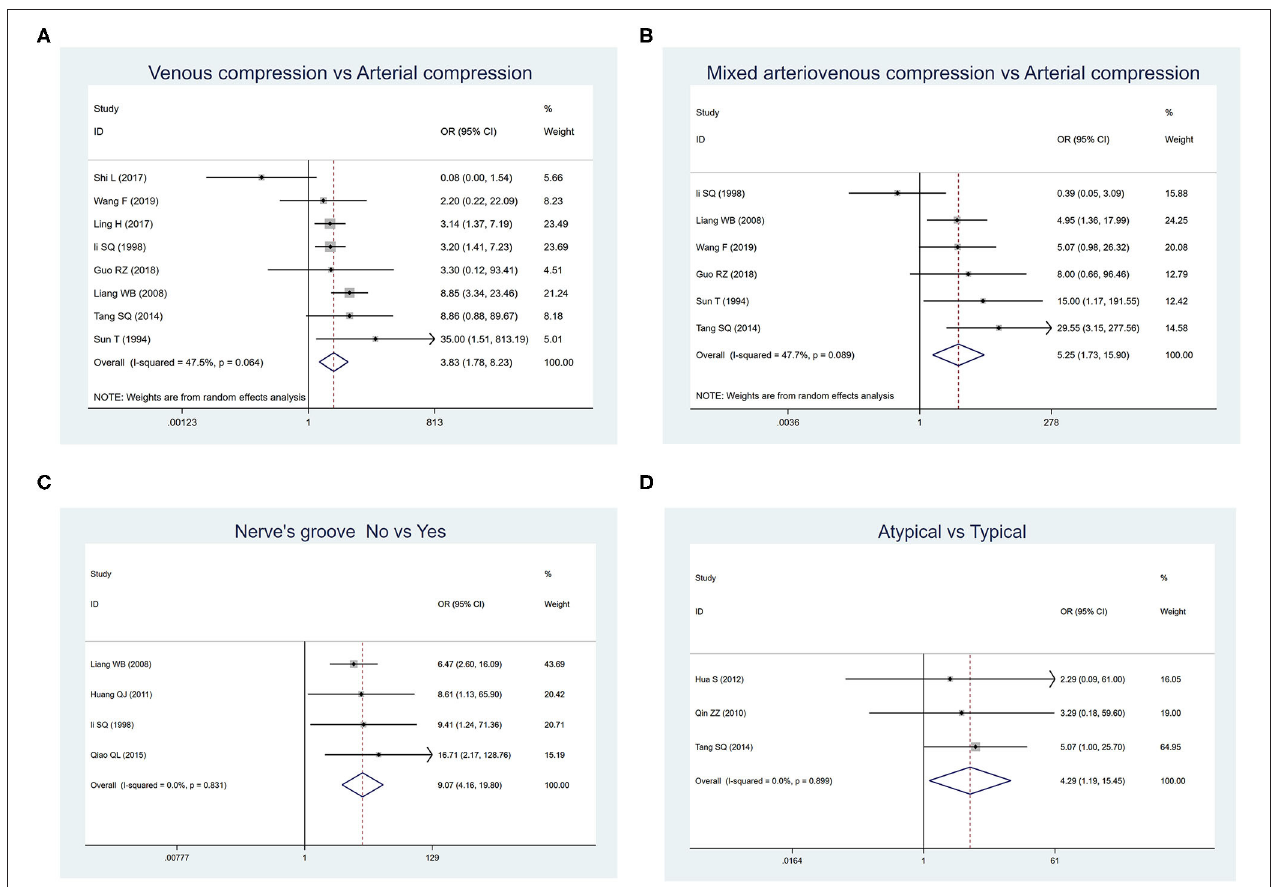
FIGURE 2 | Forest plot displaying risk factors affecting the recurrence rates of primary trigeminal neuralgia after microvascular decompression. (A) Comparison between venous compression and arterial compression groups. (B) Comparison between mixed arteriovenous compression and arterial compression groups. (C) Comparison between groups whether there were nerve grooves or not. (D) Comparison between atypical and typical symptom